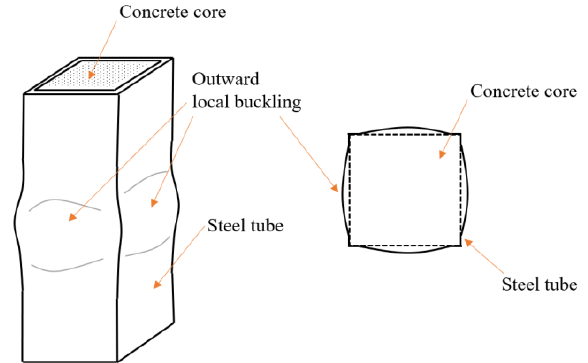
Figure 2. Schematic failure modes of rectangular CFST columns. The range and distribution of the database contents concerning the geometric details, material strengths, and ultimate strengths are presented in Figure 3. It can be seen that the concrete strengths ( f ′ c ) of the database specimens range from 15 MPa to 120 MPa, and most of them have a value of f ′ c between 30 and 50 MPa. Additionally, the yield strength of the steel tube ( f y ) varies from 180 MPa to 840 MPa and mostly ranged between 180 and 300 MPa. The confinement factor [ ξ = ( A s f y )/( A c f’ c )] is distributed between 0.2 and 10.5. Addi- tionally, most of the included specimens have a steel ratio [ ρ = A s / A c ] between 2% and 20%, while just a few specimens have a larger ratio. The column width-to-steel thickness ratio (b/t) ranged from 10 to 135. The ultimate section capacity ( N u ) varied from 190 to 15,000 KN.